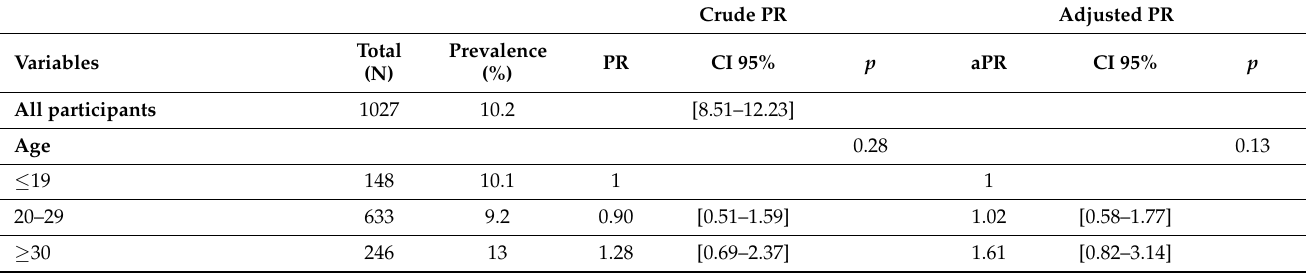
Table 2. Alcohol consumption among pregnant women and associated factors in rural and semi-urban Burkina Faso 2019 (Crude, adjusted prevalence ratio, and 95%